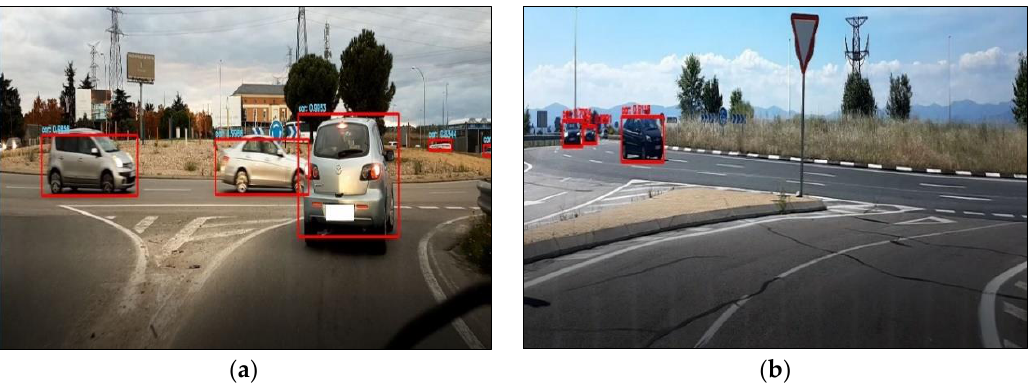
Figure 8. Snapshots of vehicle detection using the You Only Look Once (YOLO) framework, ( a ) Vehicles in front of and to the right, ( b ) Vehicles to the right.